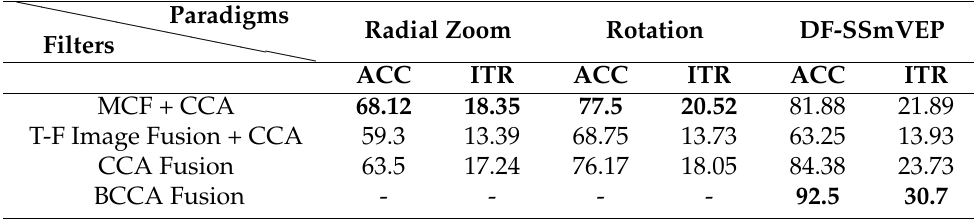
Table 1. Mean accuracy (%) and mean ITR (bits/min) comparison between four methods of spatial filtering across the three motions. The best ITR among different time windows are reported for each filter. Maximum Contrast Fusion (MCF) [20] and T-F Image Fusion [17] are two types of spatial filtering.